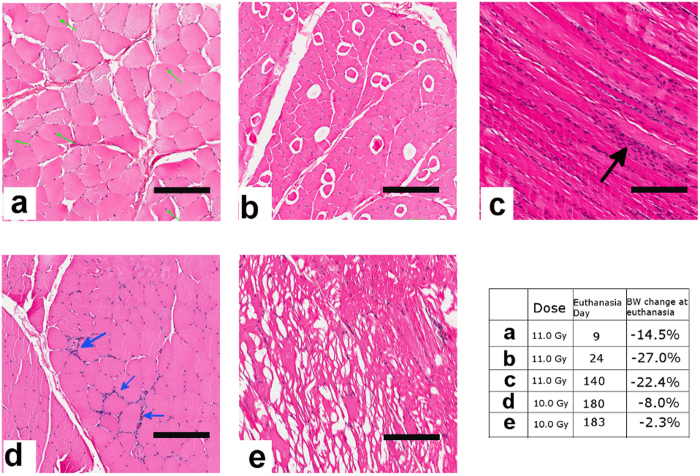
Histological morphology of muscle tissue from five NHP exposed to 10 or 11 Gy PBI/BM5.(a) Central nuclei: muscle nuclei (green arrows) are located inside rather than at the periphery of the muscle fibers; (b) Adipose replacement of muscle fibers. The hydrophobic fat-rich structures in adipocytes show a clear cytoplasm structure; (c) Polynuclei in muscle fibers (black arrows); (d) inflammatory cell (blue arrows) infiltration of muscle fibers; and (e) branched muscle fibers (left part of the muscle tissue). The table shows radiation doses, time of euthanasia, and BW change at euthanasia compared to pre-irradiation BW for each of the five animals. Scale bar = 100 micron.